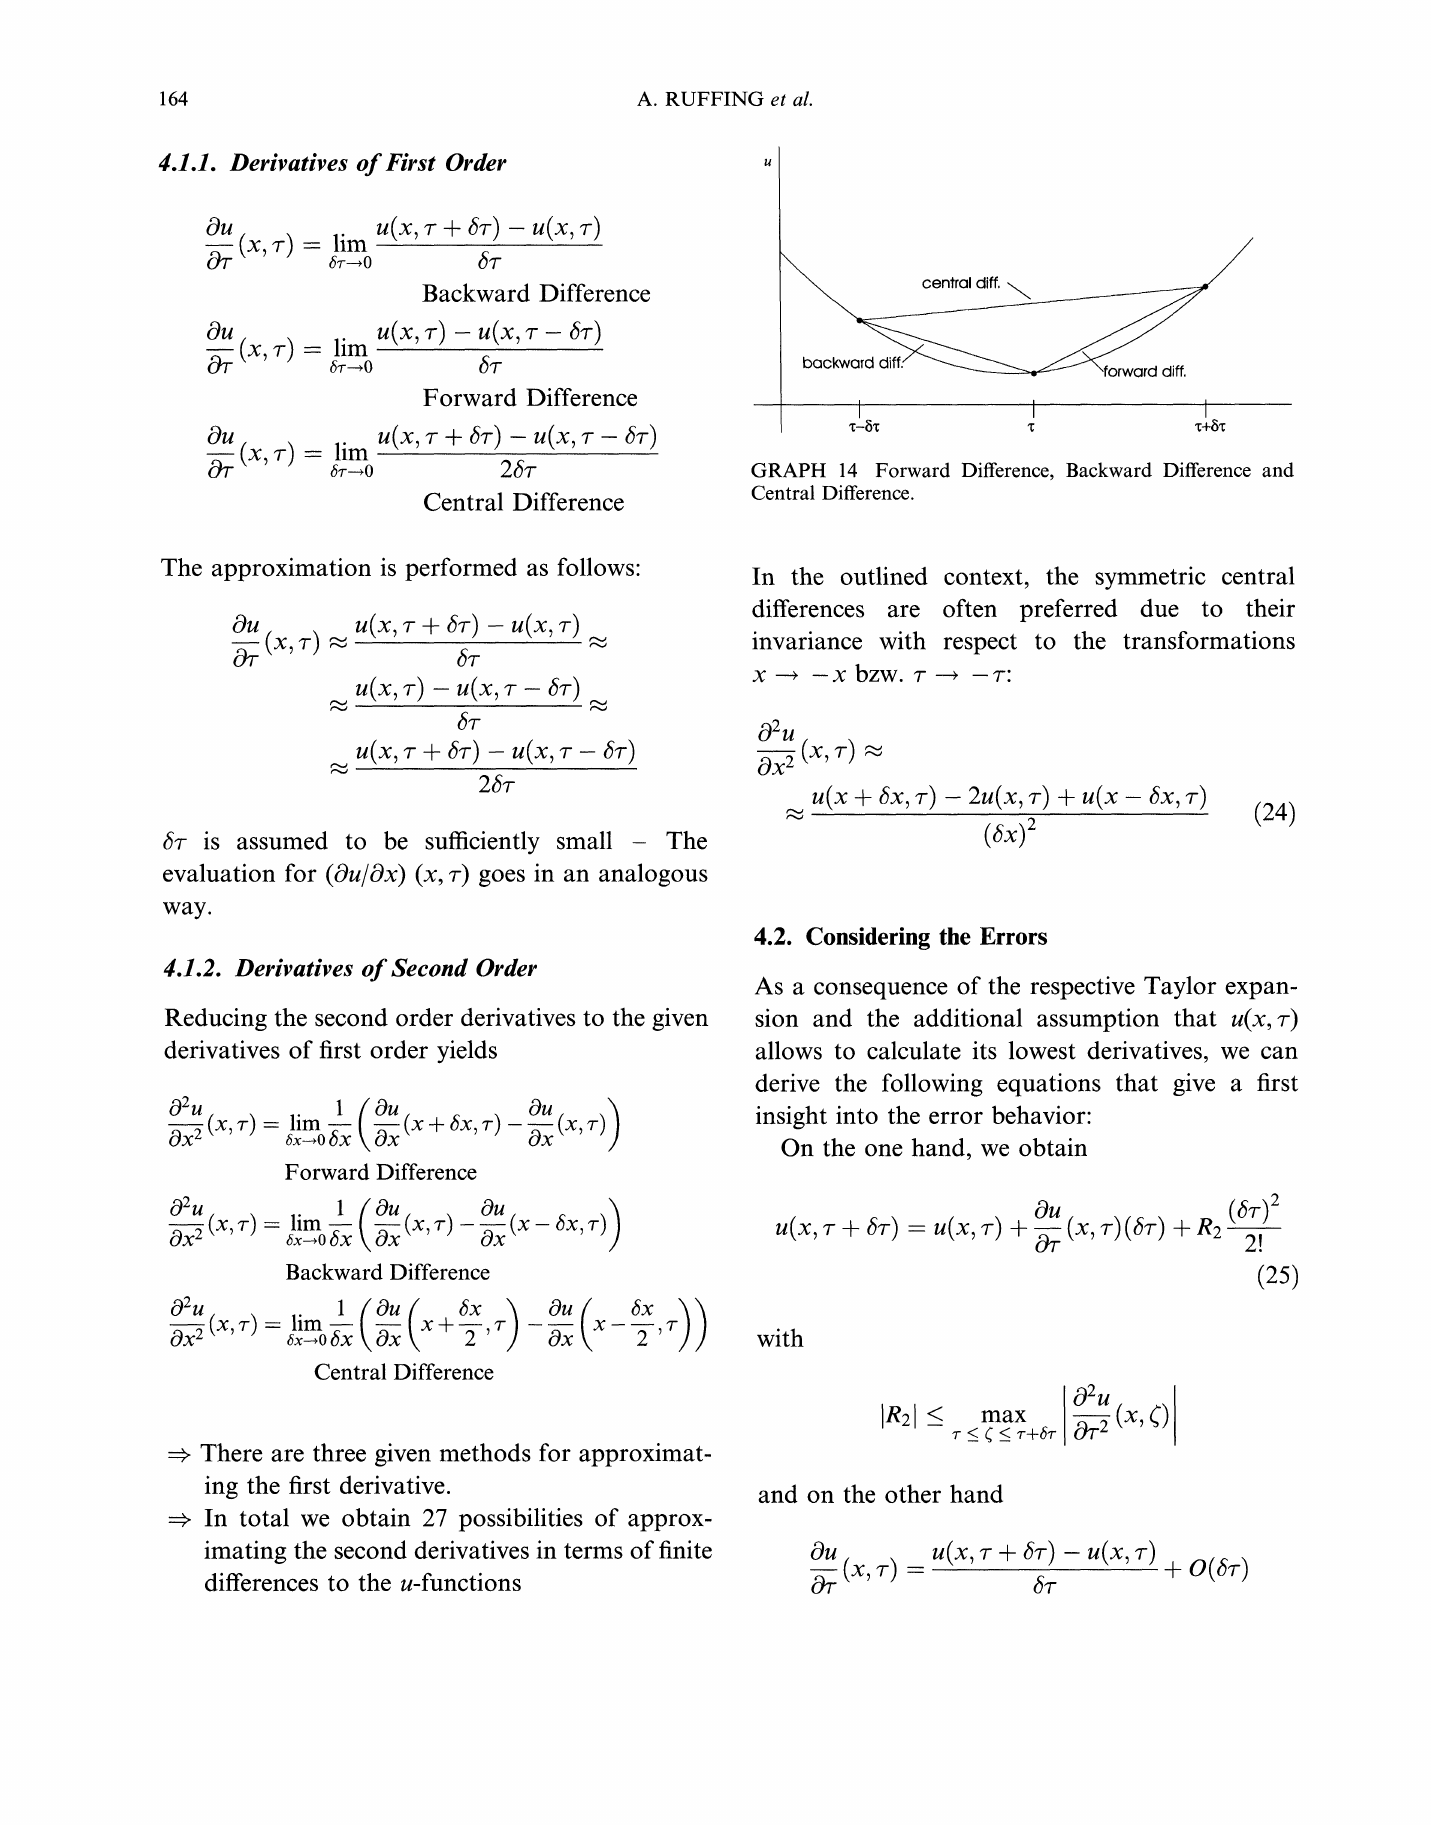
backward diff. forward diff